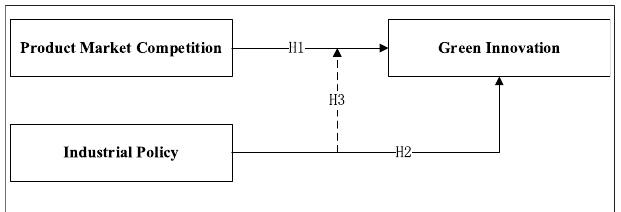
FIGURE 3 | Conceptual